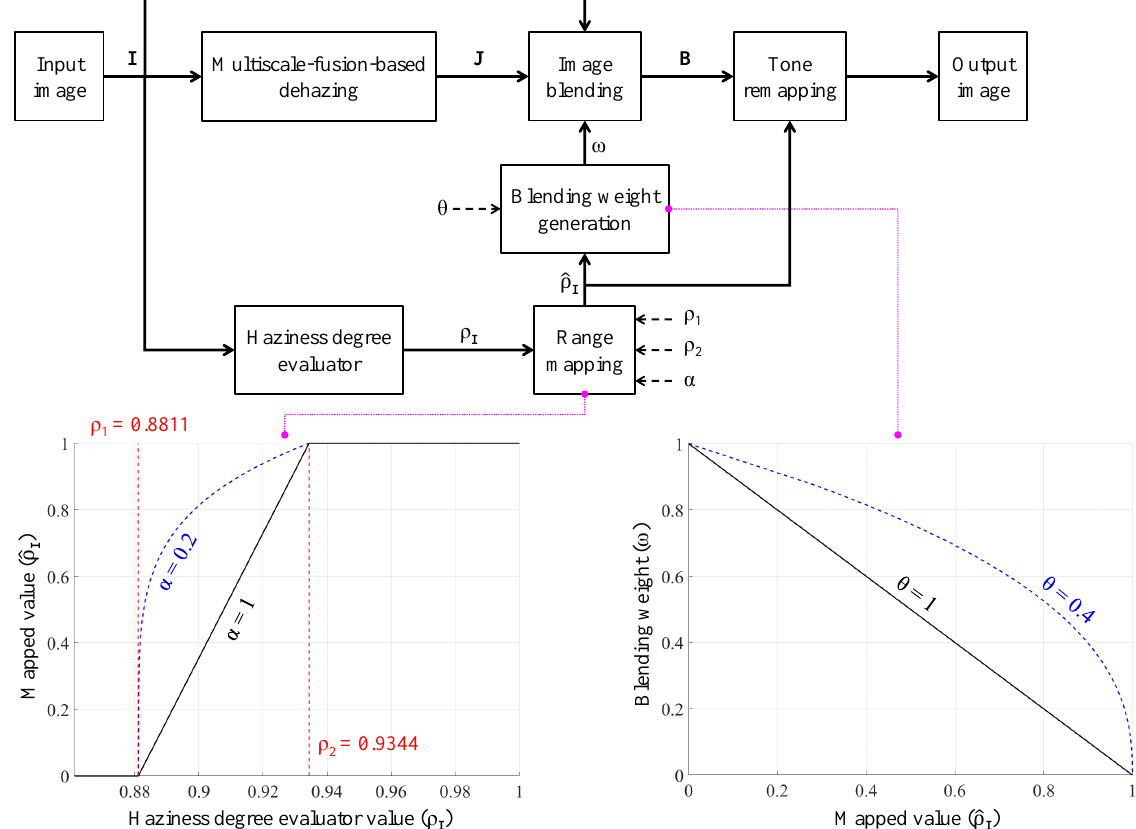
Figure 6. Detailed block diagram of the AUDS demonstrating the exploitation of haziness degree evaluator to guide image blending and tone